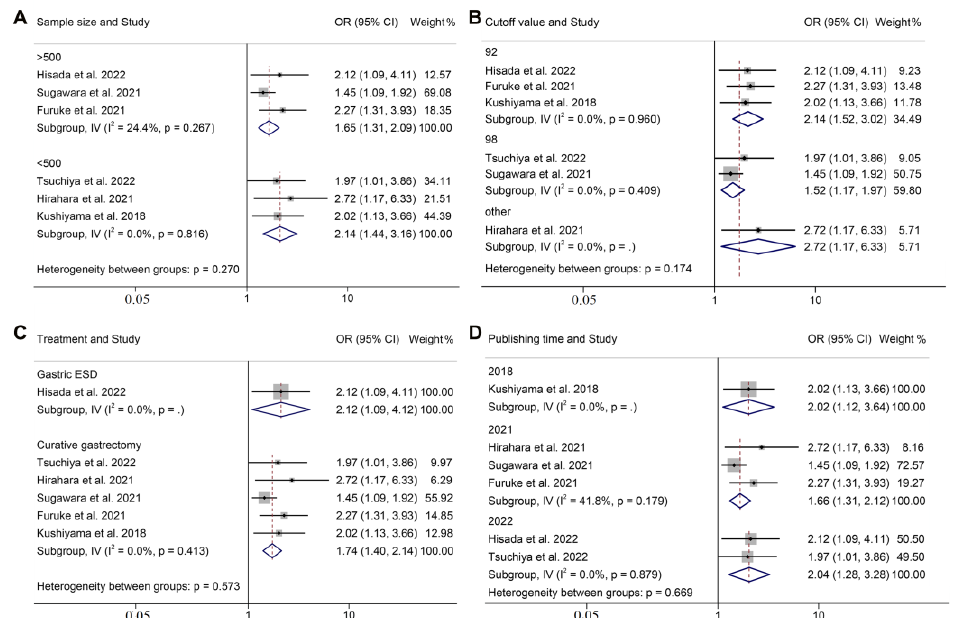
Figure 5. Subgroup analysis of postoperative complications based on sample size ( A ), cut-off value ( B ), treatment ( C ), and publishing year ( D ). ESD, endoscopic submucosal dissection; OR, odds ratio; CL, confidence interval [14,16 –